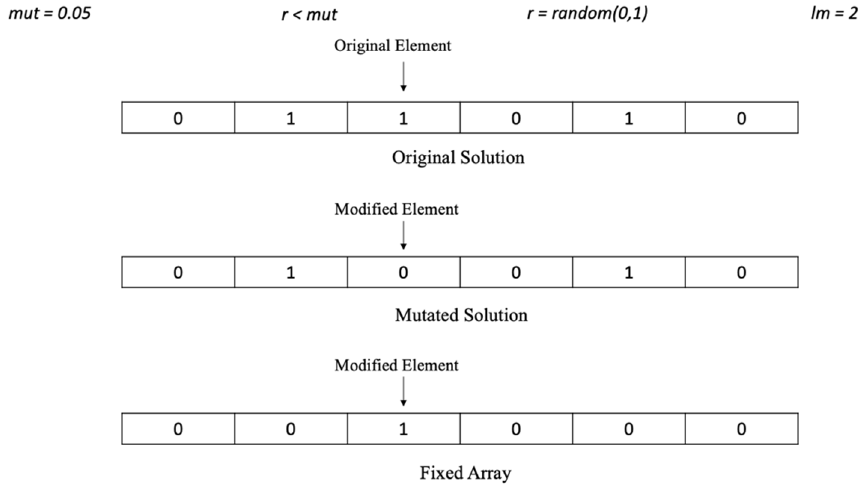
Figure 7. Fixed Mutation operator example.